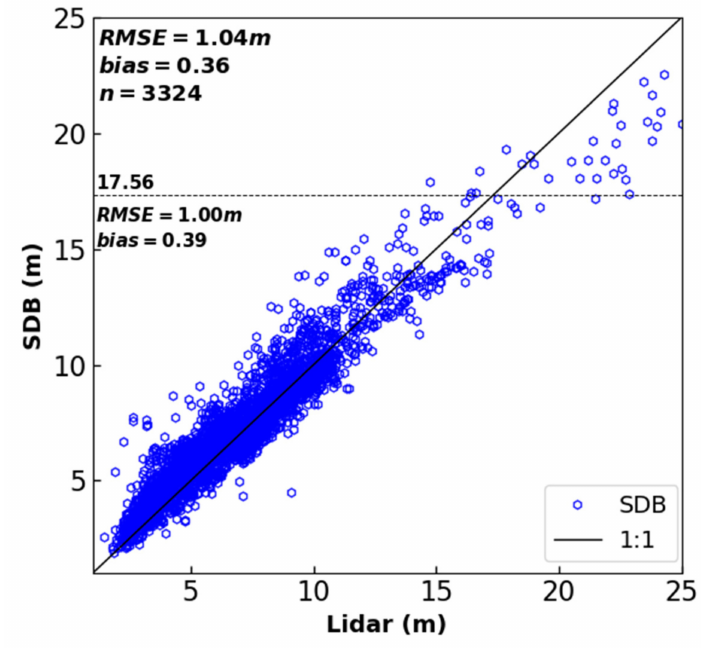
Figure 7. Scatterplots of ensemble-based satellite-derived bathymetry estimates vs. LiDAR measurements. Blue dots show estimates obtained after applying a correction to the R rs images. The solid line represents the 1:1 relationship. The dotted line shows the per-scene depth threshold value and its statistical